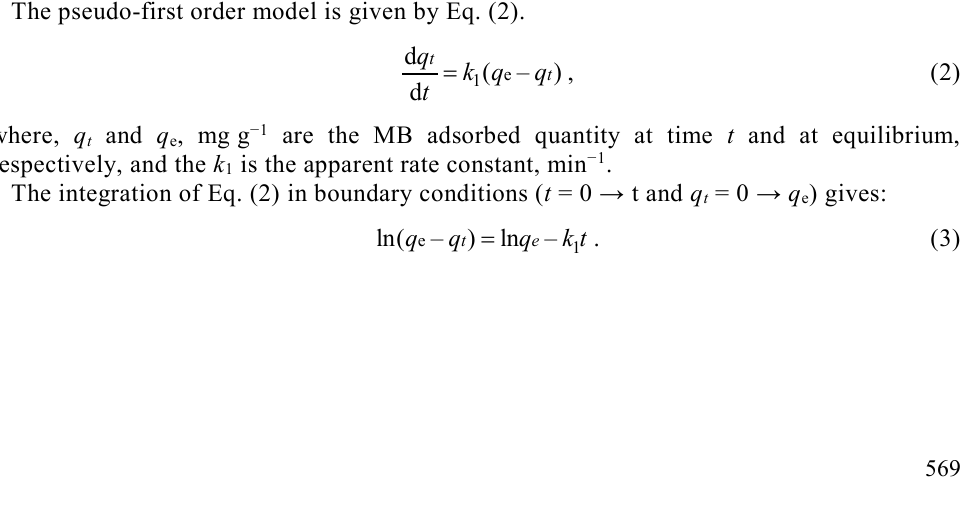
where, q t and q e , mg g −1 are the MB adsorbed quantity at time t and at equilibrium, respectively, and the k 1 is the apparent rate constant, min −1 . The integration of Eq. (2) in boundary conditions ( t = 0 → t and q t = 0 → q e )